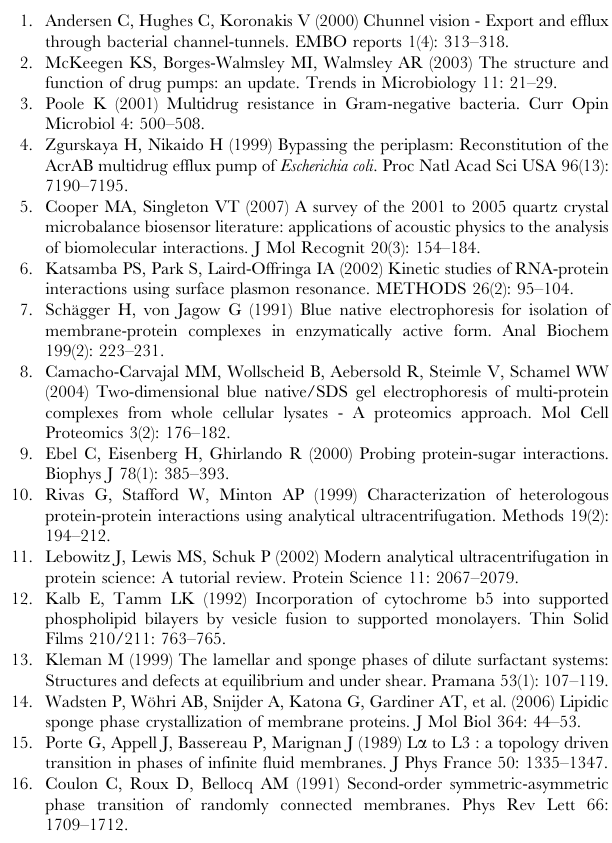
Figure S2 Freeze fracture electron micrograph of the L3 phase. Freeze-fracture electron microscopy realized for a L3 phase of Q m = 0.25. Found at: doi:10.1371/journal.pone.0005035.s002 (0.96 MB TIF) Figure S3 Ultraviolet CD spectra of proteins MexA and OprM. Far UV CD spectra performed on: (i) lipid anchored membrane protein MexA in a solution of b -OG (- - -(black)) (ii) MexA incorporated into the L3 phase (- - -(grey)), (iii) the transmembrane protein OprM in a solution of b -OG (black solid line) and (iv) OprM incorporated into the L3 phase (grey solid line). Found at: doi:10.1371/journal.pone.0005035.s003 (0.21 MB